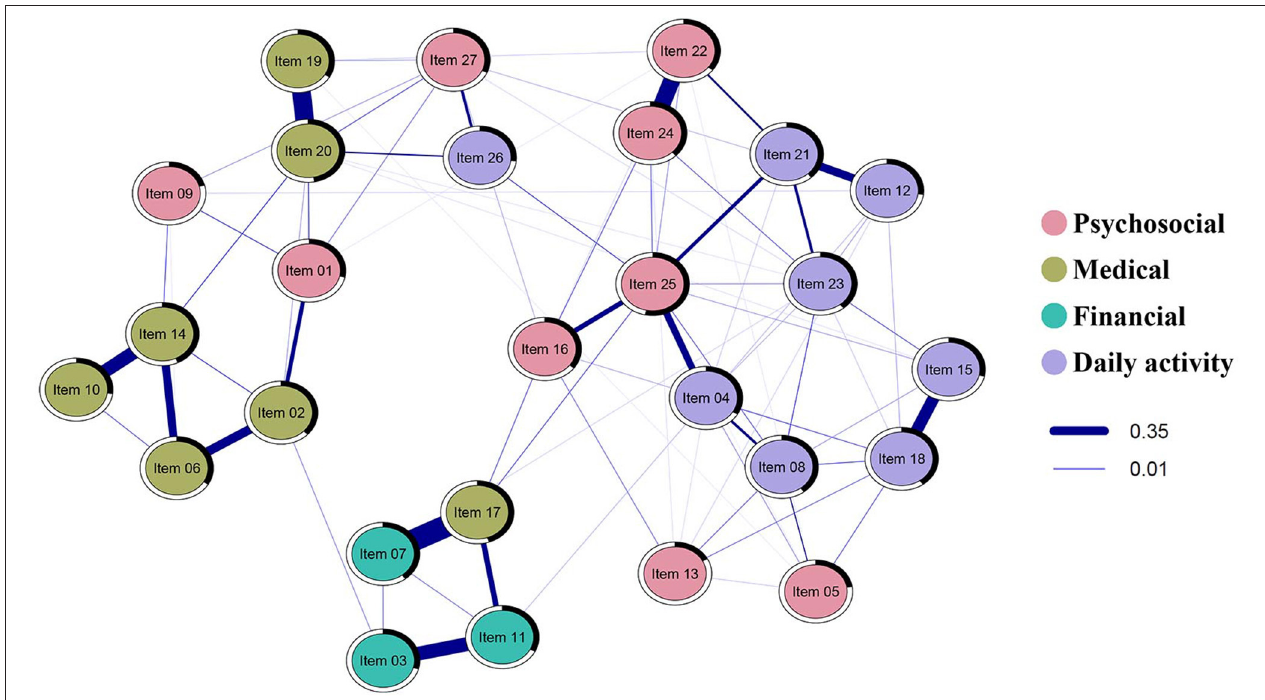
FIGURE 1 | Estimated regularized partial correlation network plot for the NAFC-C ( N = 363). Only edges that have associations are shown. Blue lines show the positive association between needs; the thickness of the lines represents the strength of the association between needs. The thicker the line, the stronger the relationship between the two needs. The black area around the rings shows the predictability, the variance of a given node explained by all its neighbors. Nodes are colored by their factors in the NAFC; psychosocial needs are colored red, medical needs are colored olive, financial needs are colored green, daily activity needs are colored